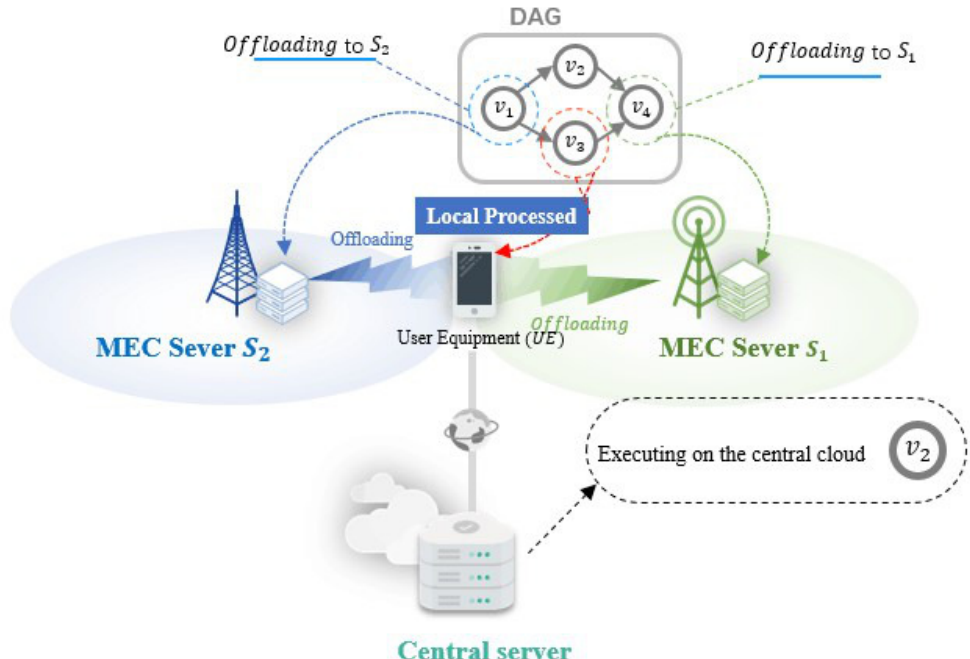
Figure 2. An offloading model of a MEC system.